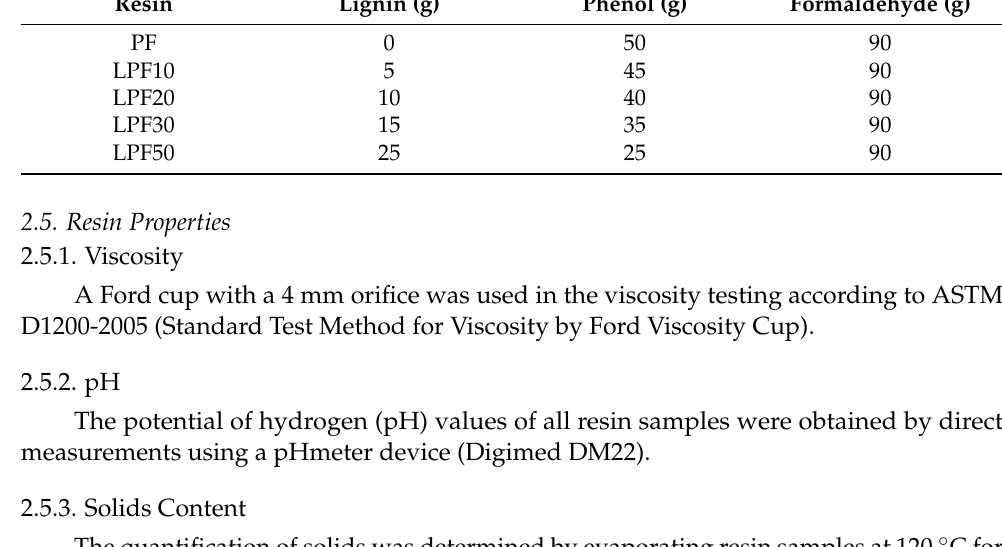
Table 1. Amounts of reagents used in the syntheses of LPF resins.